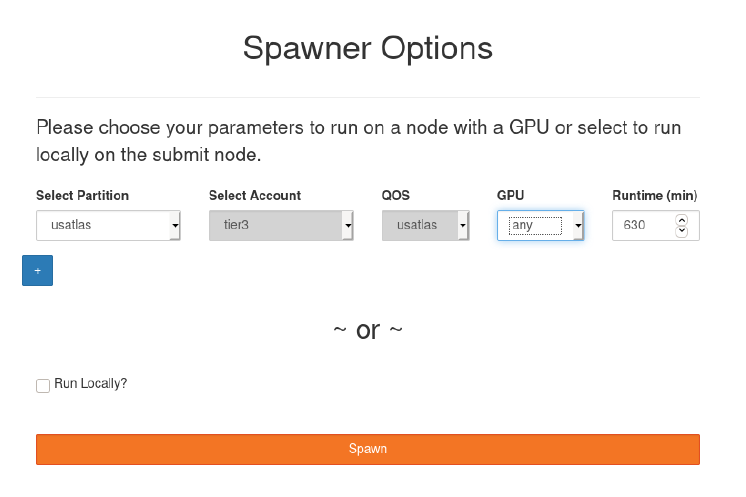
Figure 4. Example of the custom Slurm spawner interface. The user can request to run locally or on the GPU-based HPC cluster. The form only provides options that are available to the given